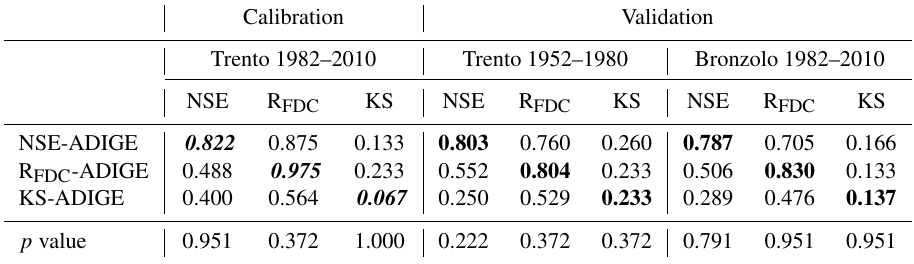
Table 3. Efficiency metrics for calibration and validation runs obtained using the ADIGE dataset as input forcing. The terms NSE-ADIGE, KS-ADIGE and R FDC -ADIGE refer to the parameterizations described in Sect. 3.4. Bold italic numbers indicate the metric optimized in the calibration. The p values of the Kolmogorov–Smirnov (KS) test are also reported (bottom line) for the calibration experiments and the validation runs highlighted by bold